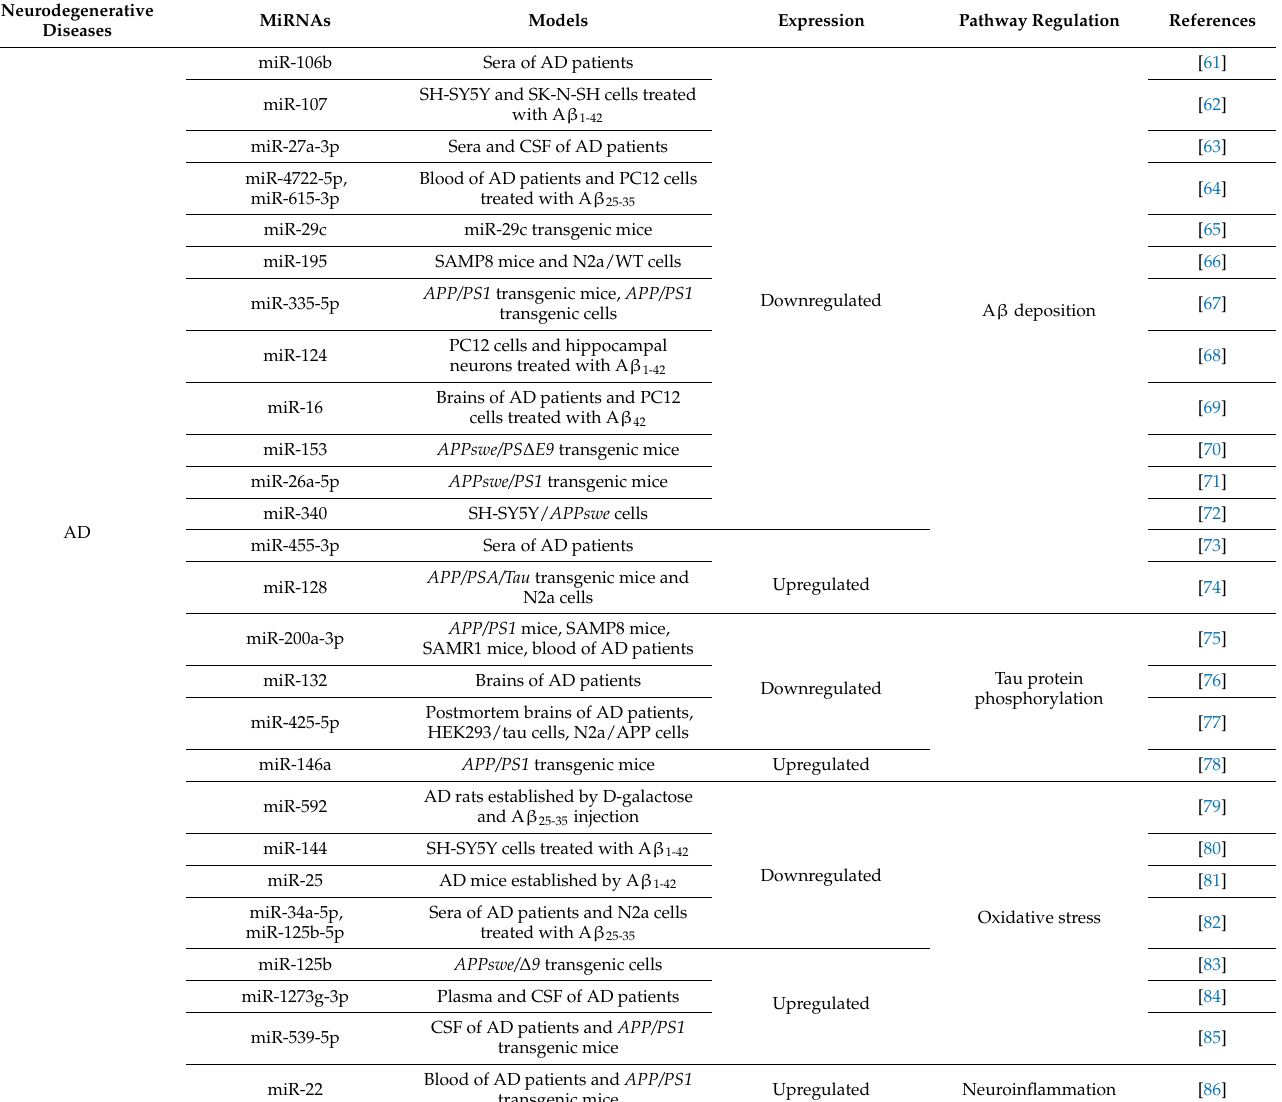
Table 1. MiRNAs involved in pathological changes of neurodegenerative diseases. Neurodegenerative Diseases MiRNAs Models Expression Pathway